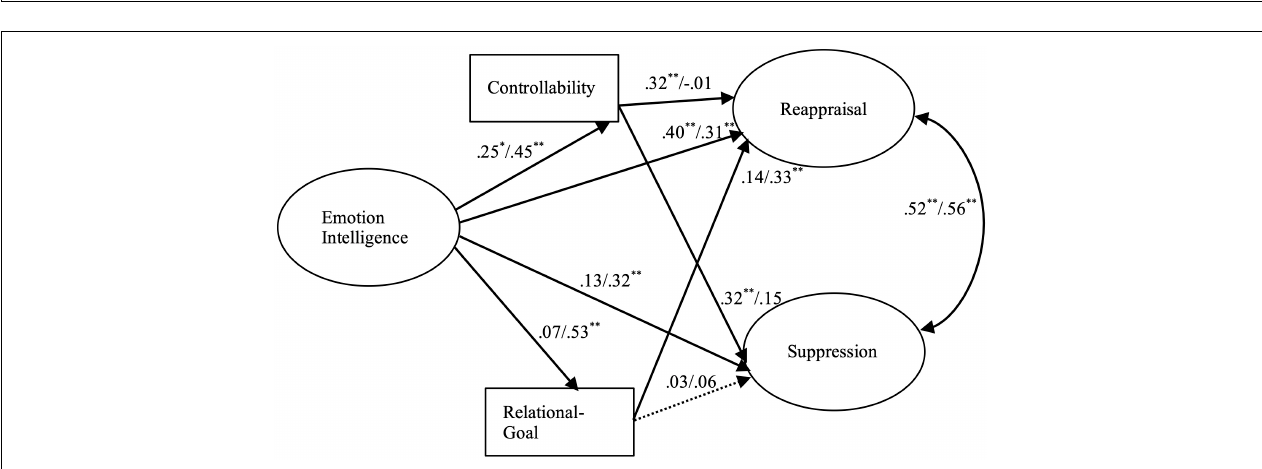
FIGURE 2 | The structural mode of emotion regulation with partners. Dashed lines indicate non-significant paths. The values are the path coefficients for females (left side) and males (right side). N = 300. ∗ p < 0.05. ∗∗ p < 0.01.